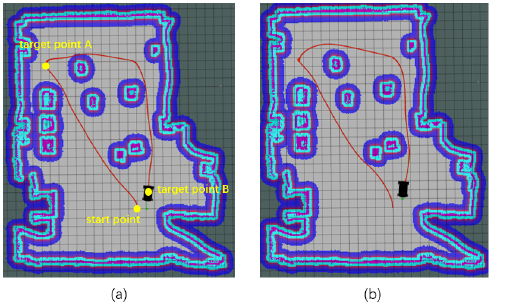
Figure 8. Trajectory comparison in RViz. ( a ) Trajectory using the DWA algorithm. ( b ) Trajectory using the improved VFH* algorithm.